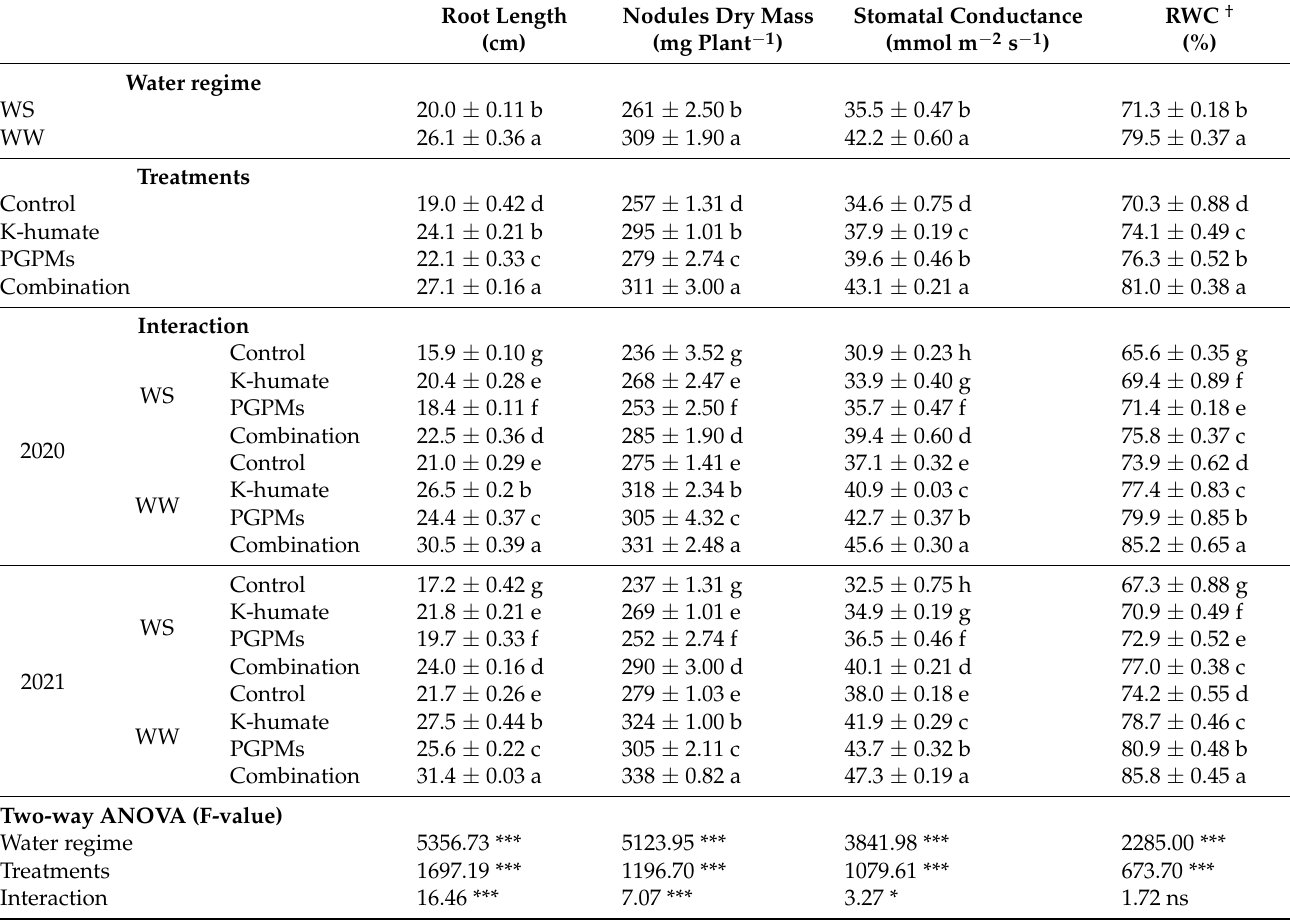
Table 1. Some physical features of soybean plants ( Glycine max L. cv. Giza 111) which were cultivated in salt-affected soil and treated with plant growth-promoting microbes (PGPMs; Bradyrhizobium japon- icum (USDA 110) and Trichoderma harzianum ), potassium humate (K-humate), and their combination under two water regimes (WS: water deficit regime and WW: well-watered regime) during two consecutive